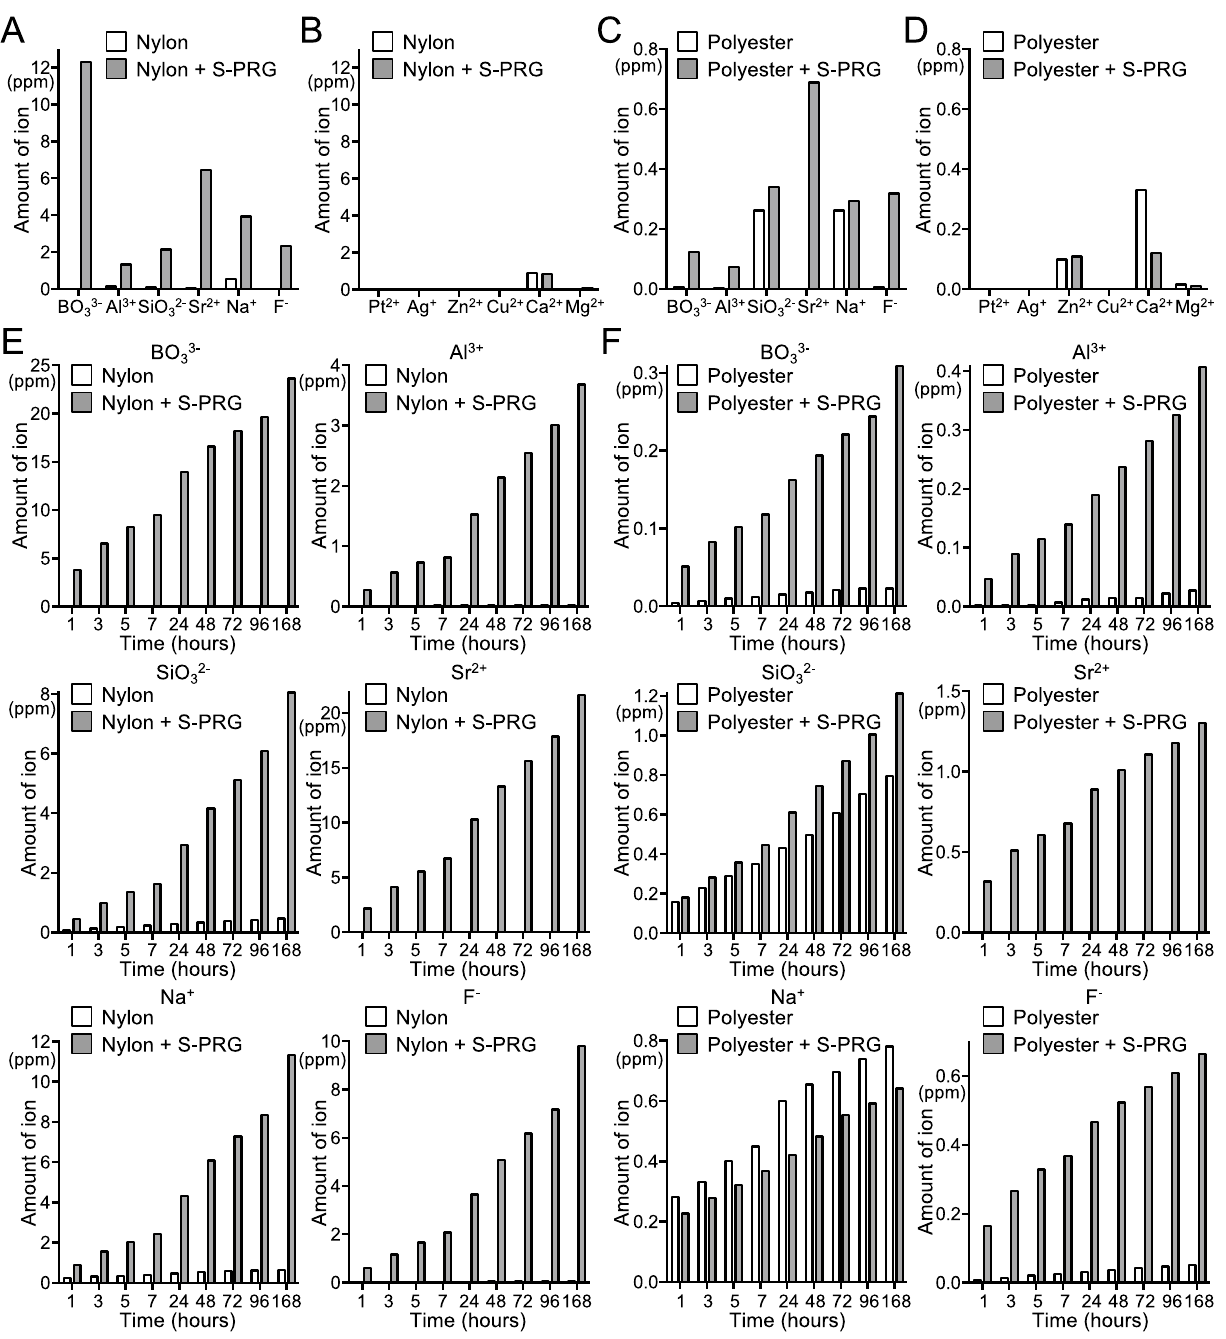
Figure 2. Ion concentrations released from monofilaments. ( A – D ) Ion concentrations released from monofilaments into sterilised distilled water after mixing for 18 h. Amounts of ions derived from S-PRG filler ( A ) and not derived from S-PRG filler ( B ) in nylon monofilaments. Amounts of ions derived from S-PRG filler ( C ) and not derived from S-PRG filler ( D ) in polyester monofilaments. ( E , F ) Cumulative ion concentrations released from monofilaments into sterilised distilled water, which was replaced after 1, 3, 5, 7, 24, 48, 72, 96, 168 h. Nylon monofilaments ( E ) and polyester monofilaments ( F